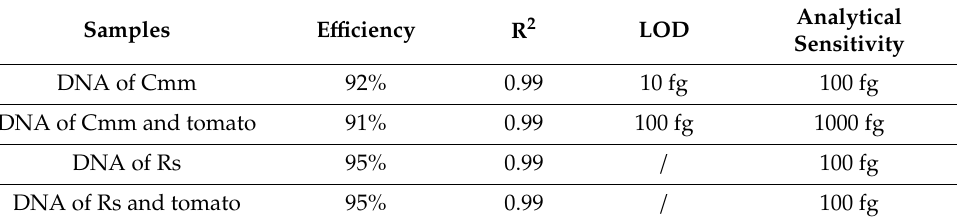
Analytical Sensitivity